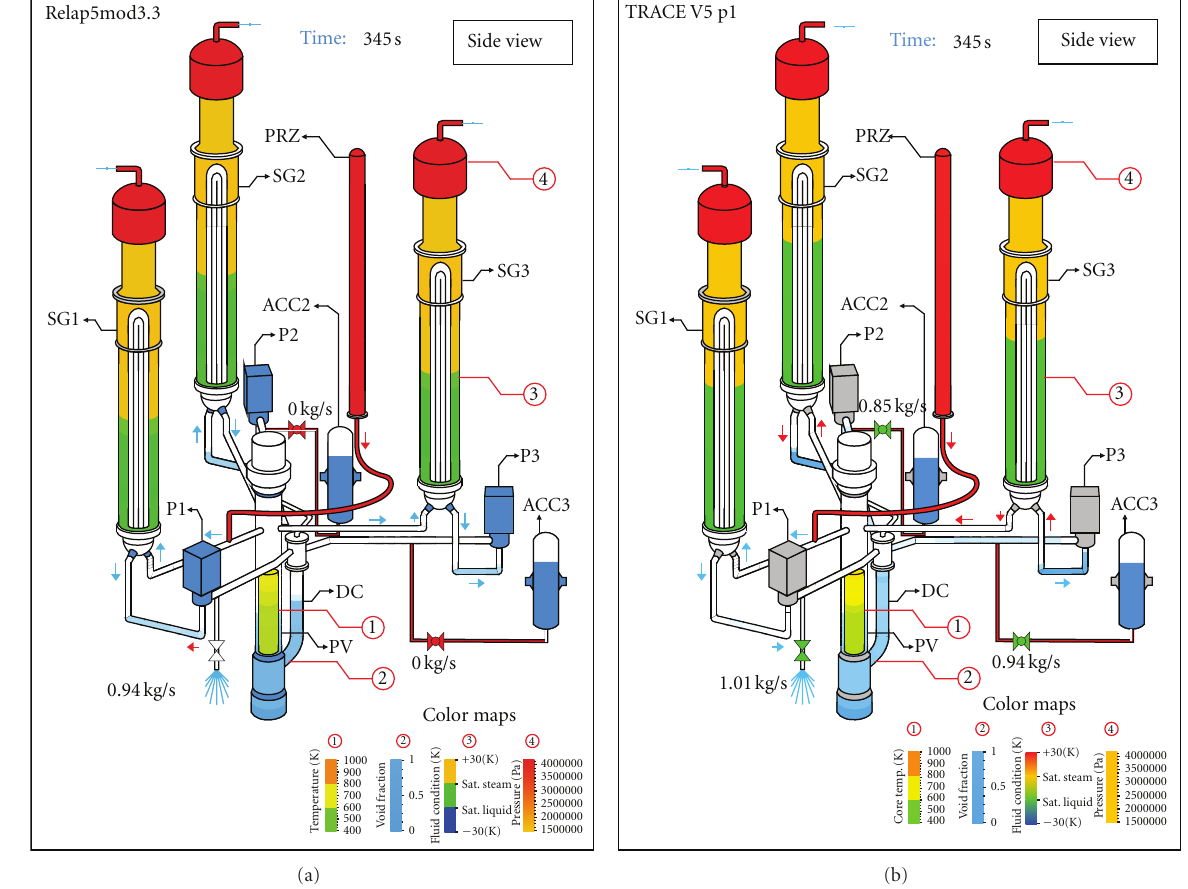
Figure 21: Animation mask for RELAP5 (a) and TRACE (b) at time t = 345 s (loop seal clearance).